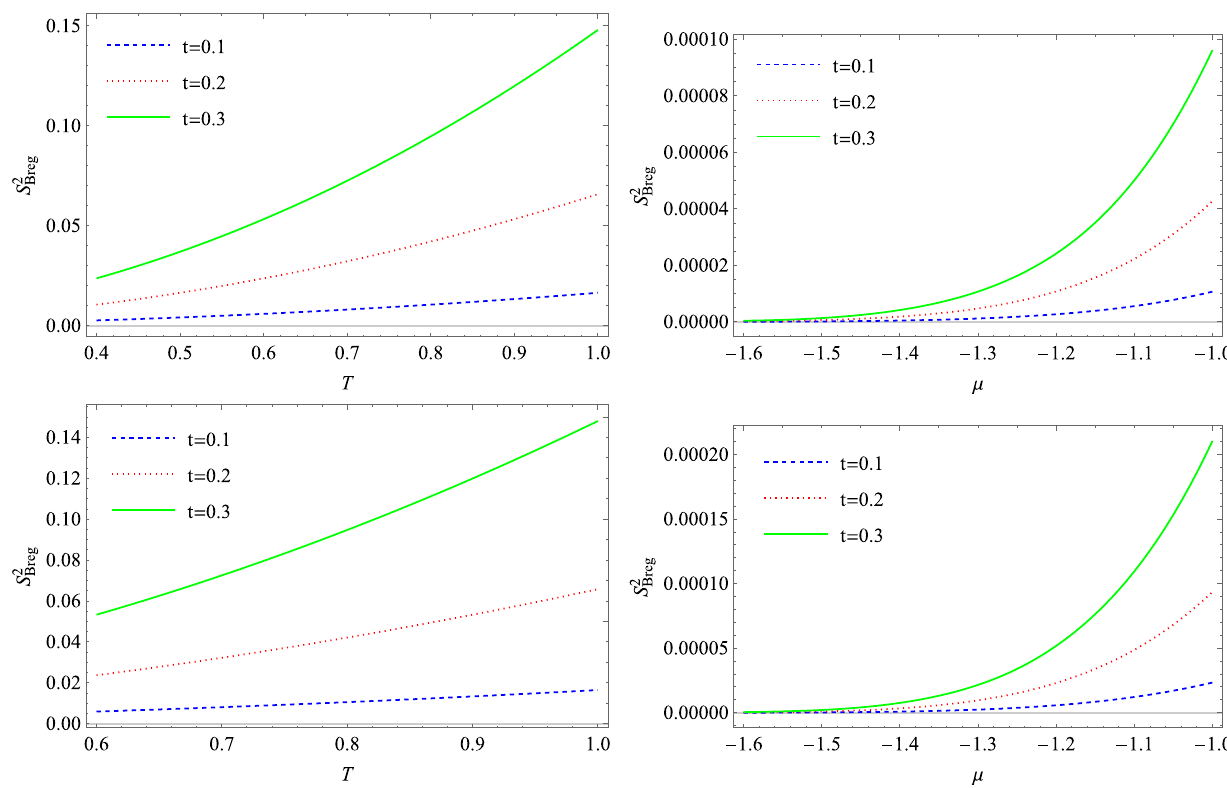
Fig. 5 Bosonic regularized mean square displacement s 2 as a function of the temperature T or the chemical potential μ for the short time Breg approximation, Eq.(71), for some values of the time t . Upper panels: positive fixed value of k . Lower panels: negative fixed value of